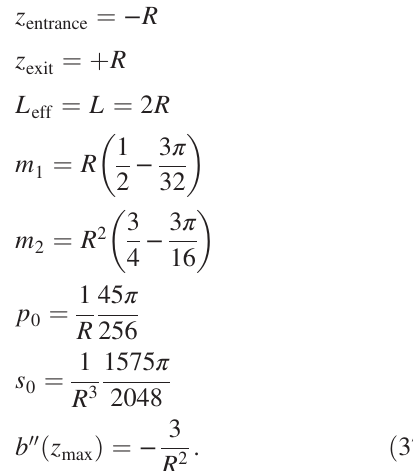
ffiffiffiffiffiffiffiffiffiffiffiffiffiffiffi p x 2 þ y 2